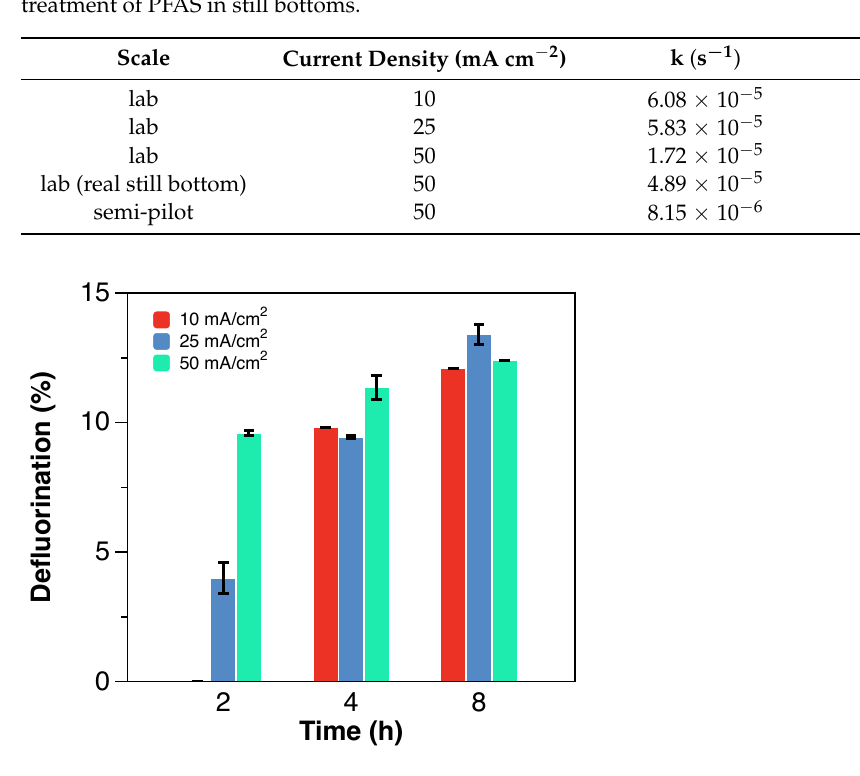
Figure A4. Defluorination percentage during the electrochemical treatment of a synthetic still bottoms solution with 10, 25 and 50 mA/cm 2 .